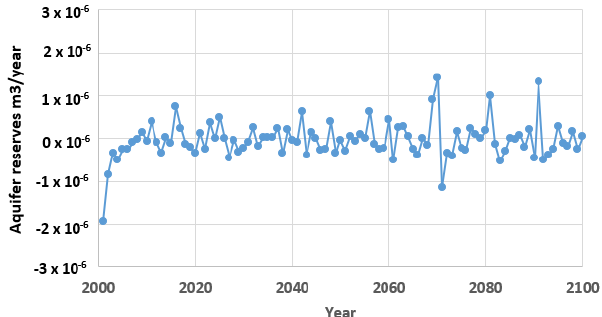
Figure A6. Changes in aquifer reserves from 2001 to 2100 under scenario RCP 4.5.